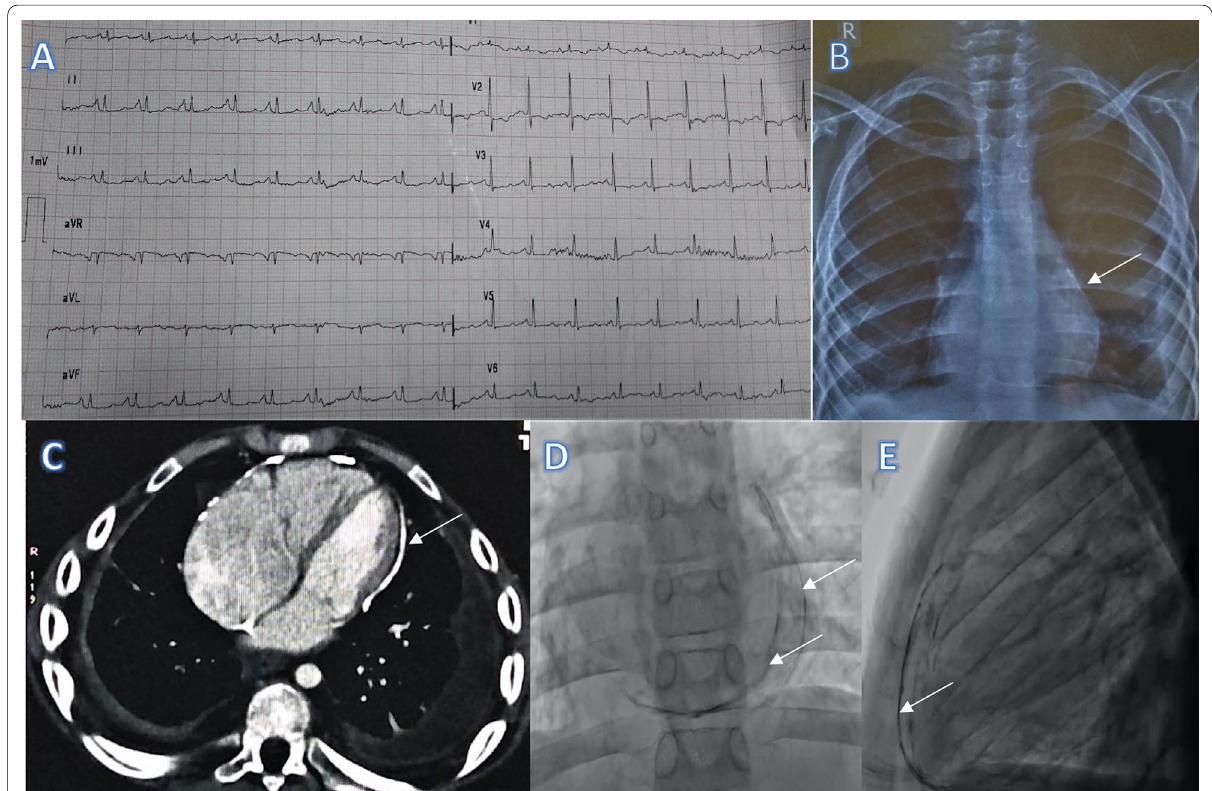
Fig. 1 A Electrocardiogram showing low-voltage QRS complexes in limb leads, left atrial enlargement and non-specific repolarisation changes. B Chest X ray PA view showing features of pulmonary venous hypertension and pericardial calcification (arrow) C CT scan image showing pericardial calcification D Cine fluoroscopy in AP view showing pericardial calcification E Cine fluoroscopy in lateral view showing pericardial